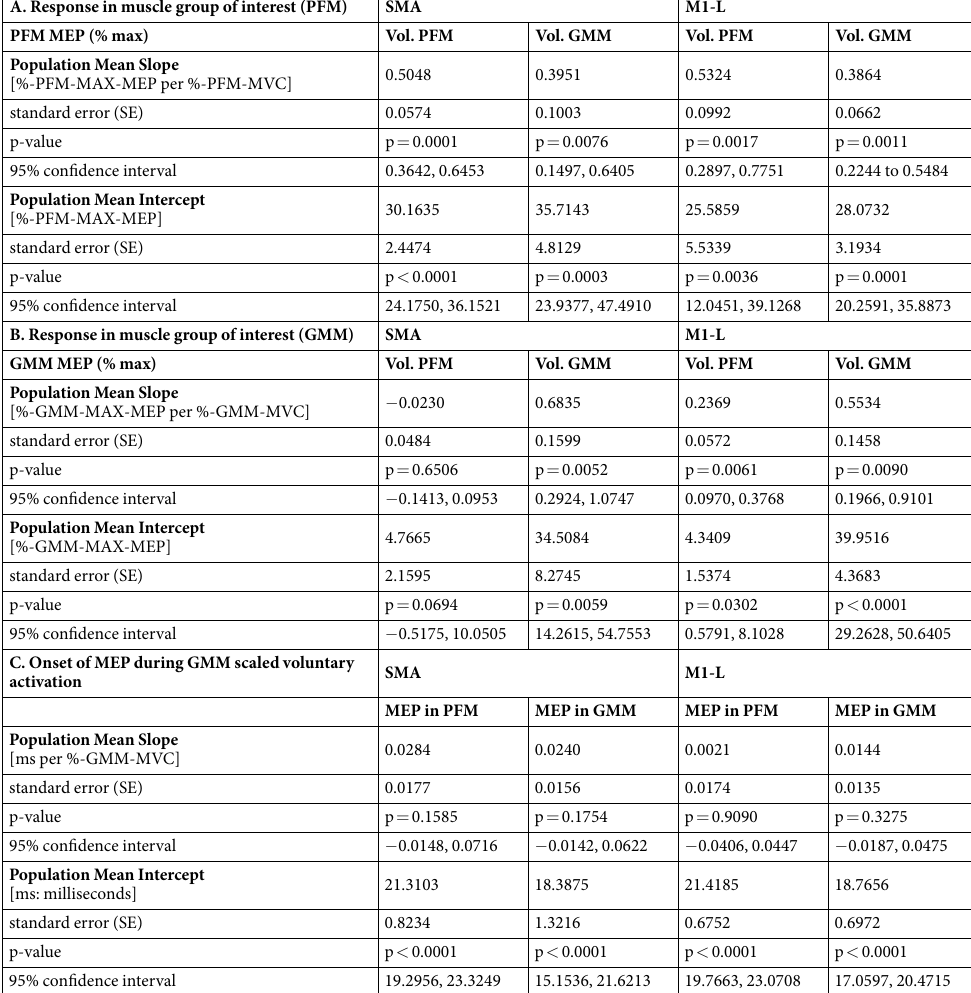
Table 3. Motor evoked potentials (MEPs) during scaled voluntary muscle activation. Activating the isolated- pelvic coordination pattern, scaling PFM voluntary activation (columns 2 & 4) was not associated with induction of MEPs in the GMM, as expected from the EMG study results. Maximum co-activation of GMM [%-GMM-MVC] was small: 4.6501 while stimulating SMA and 3.9290 while stimulating M1-L. The onset difference was significant, the onset of MEPs induced in the PFM happened after the onset of the MEPs induced in the GMM, regardless of the activation level of the GMM. While stimulating SMA,